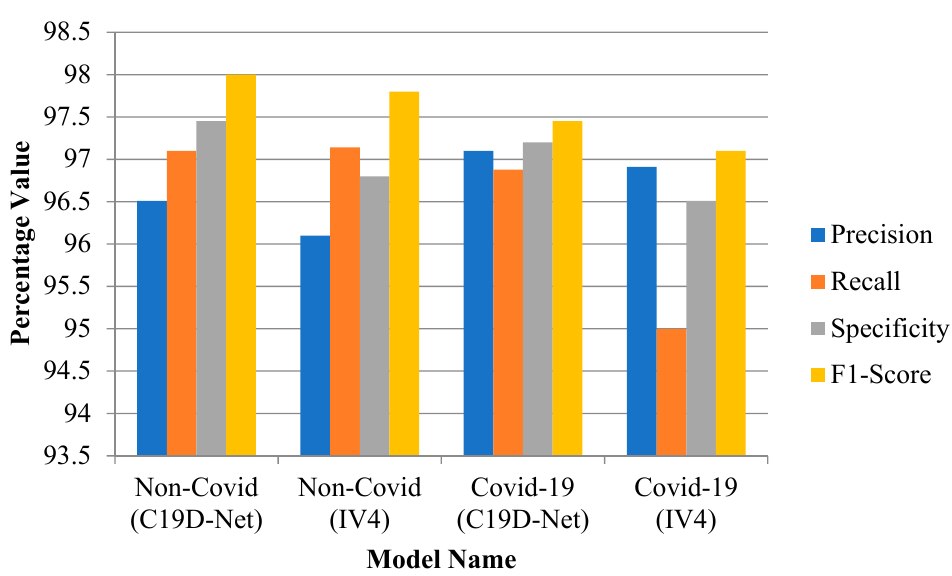
Figure 5. Evaluation performance of models with three-classes.